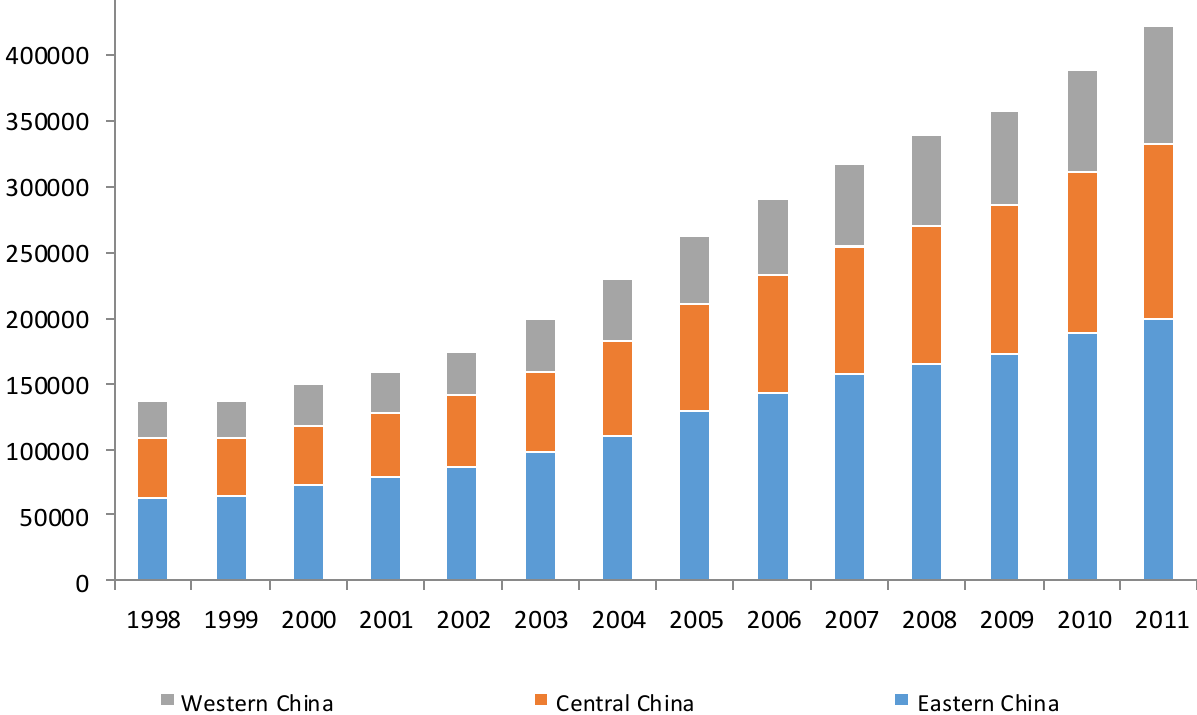
Figure 1. Energy consumption in China. Source: China Energy Statistical Yearbook [20]